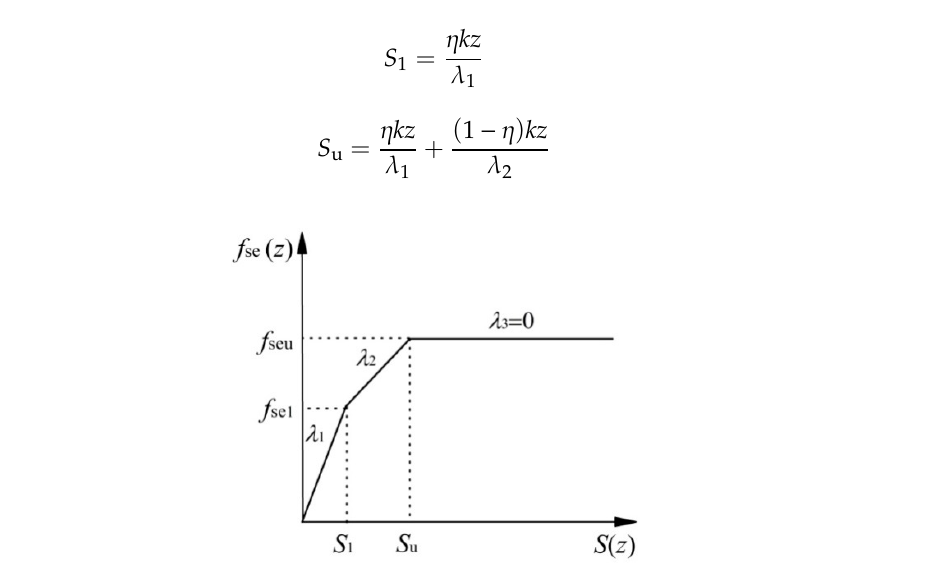
Figure 2. Load transfer trilinear model of pile-soil interface.